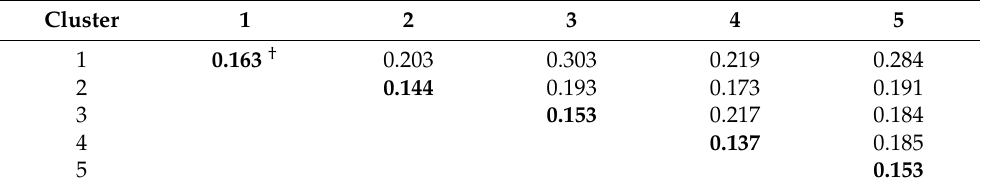
Table 6. Gower’s phenotypic distance (mean) within and among five clusters.